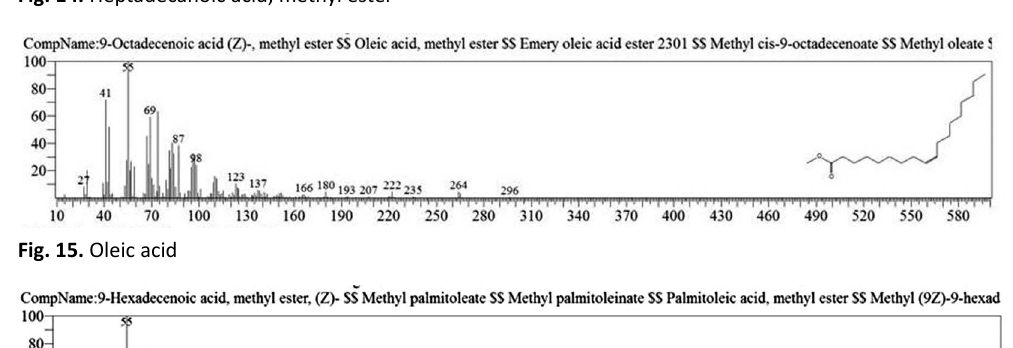
Fig. 14. Heptadecanoic acid, methyl ester